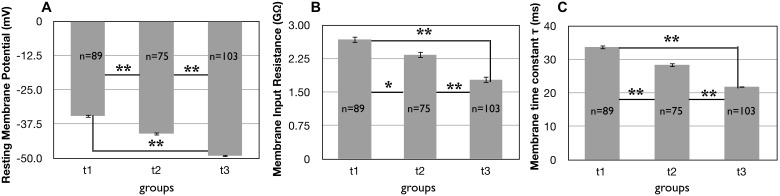
Evolution of basal membrane properties over time in iPSC-derived neurons plated on POL.A) The average resting membrane potential (RMP in mV) decreased over time. The number of cells examined for these experiments are shown inside the bar in these and the following figures. The vertical lines correspond to the SEM in this and the following figures. **: p<0.001; *: 0.001<p<0.05; NS: p>0.05 for these and the following figures. B) The membrane input resistance decreased over time (GΩ). C) The membrane time constant decreased over time (ms).